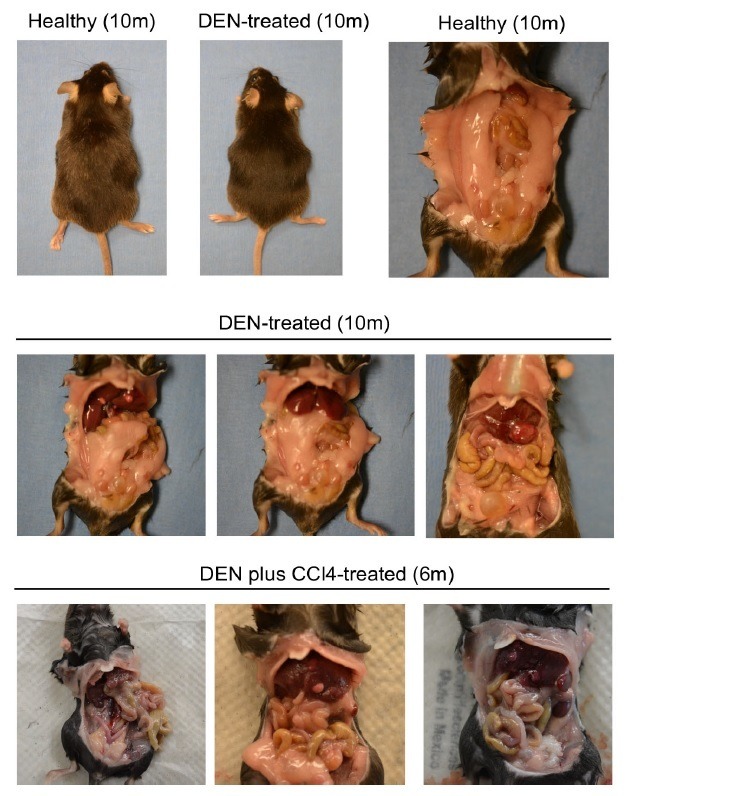
Gross anatomy of DEN and DEN plus CCL4-treated mice.